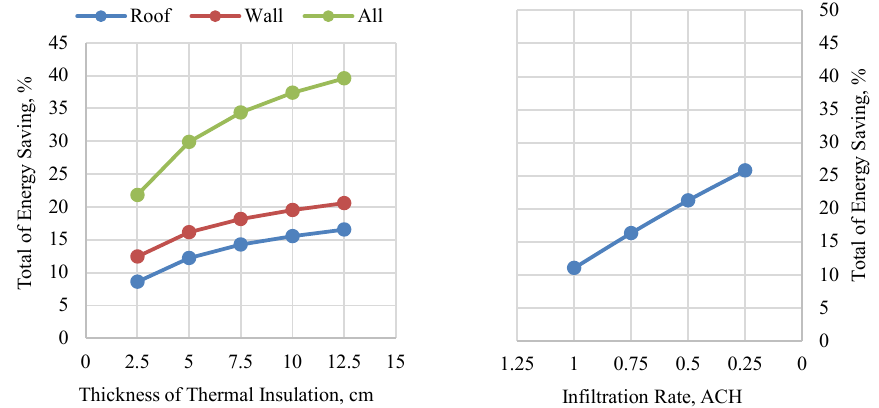
Fig. 7. Annual energy saving present from insulation (left) and infiltration rate (right) in climate zone 3.